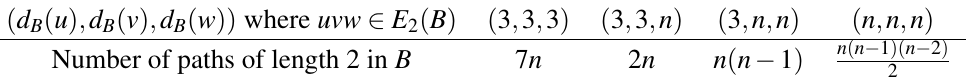
Table 7 Partition of paths of length 2 of the graph B .